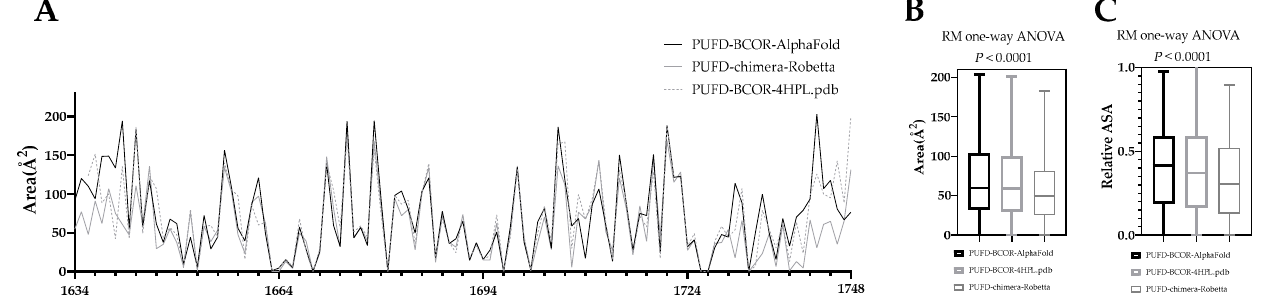
Figure 6. Determination of the accessible surface area (ASA) for the PUFD domain. The values were calculated, based on the predicted structures of the chimera (PUFD-chimera-Robetta) and the PUFD domain of BCOR (PUFD-BCOR-AlphaFold and PUFD-BCOR-4HPL.pdb). ( A ): The area (Å 2 )-based ASA, wherein the axis shows the residues of the PUFD domain (1634–1748 residues). ( B ): The RM one-way ANOVA significant difference calculation, based on the ASA area (Å 2 ). ( C ): The RM one-way ANOVA significant difference, based on a relative ASA (0–1). A significant decrease in the PUFD-chimera-Robetta area ASA ( B ) and the relative ASA ( C ) was detected, compared to the two wild-type PUFD domains ( p < 0.0001). The graph in part ( A ) shows the ASA values starting from the original amino acid 1634th, while the 1634th and 1635th residues were omitted from the RM one-way ANOVA statistical calculations ( B , C ) because these residues are missing from the PUFD-BCOR-4HPL.pdb structure (PDB ID: 4HPL).